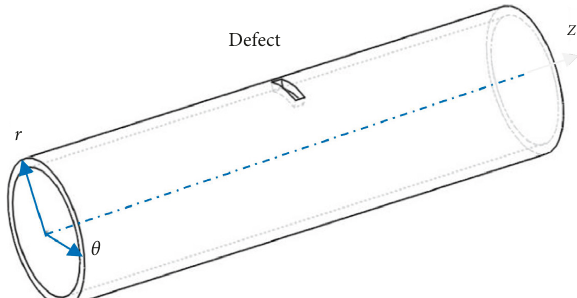
Figure 20: Schematic diagram of the cylinder coordinate system of the model.